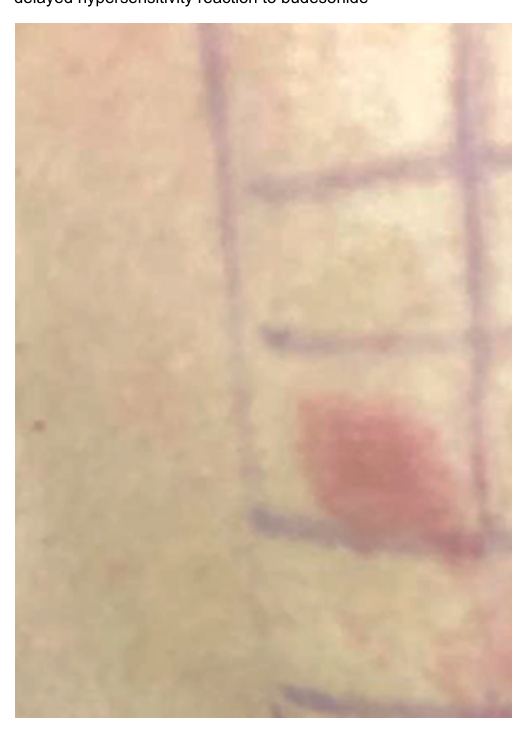
Figure 6: Positive European standard patch test in a patient with a delayed hypersensitivity reaction to